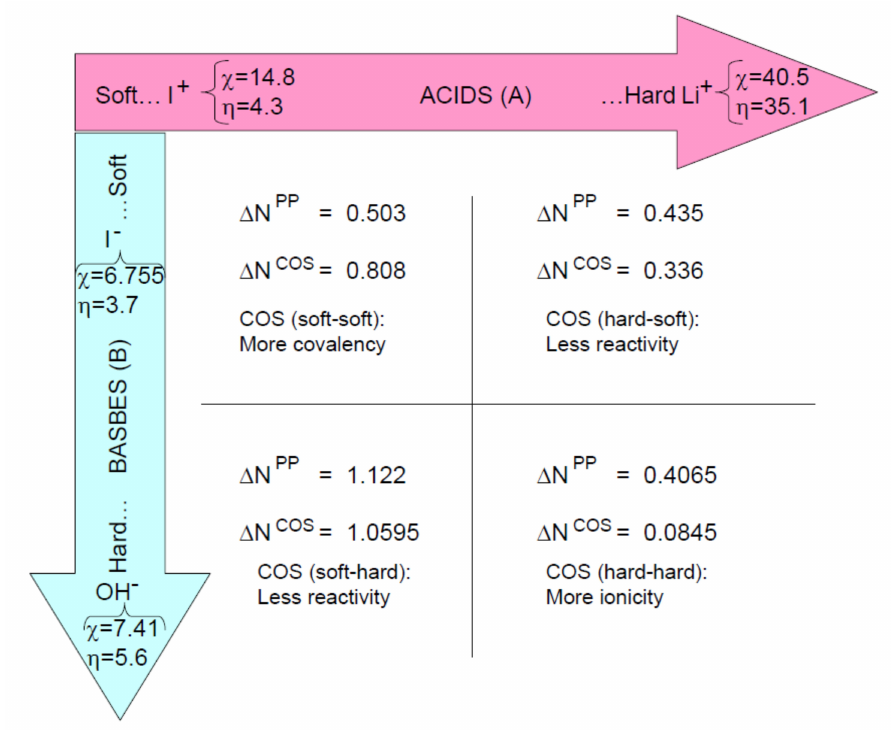
Figure A2. Hard and soft acids and bases (HSAB) principle’s verification matrix for Parr–Pearson (PP) vs. Chemical Orthogonal Space (COS) paradigms, i.e., by employing the absolute output of Equations (8) and (18), respectively. The electronegativities and chemical hardness values are in electron-volts (eV), see Ref.